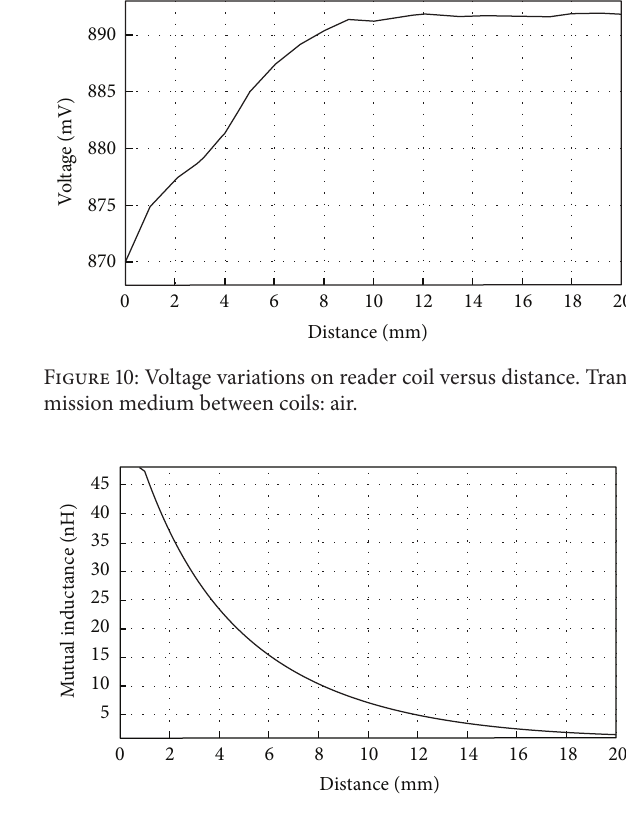
Figure 11: Mutual inductance versus distance. Transmission medium between coils: